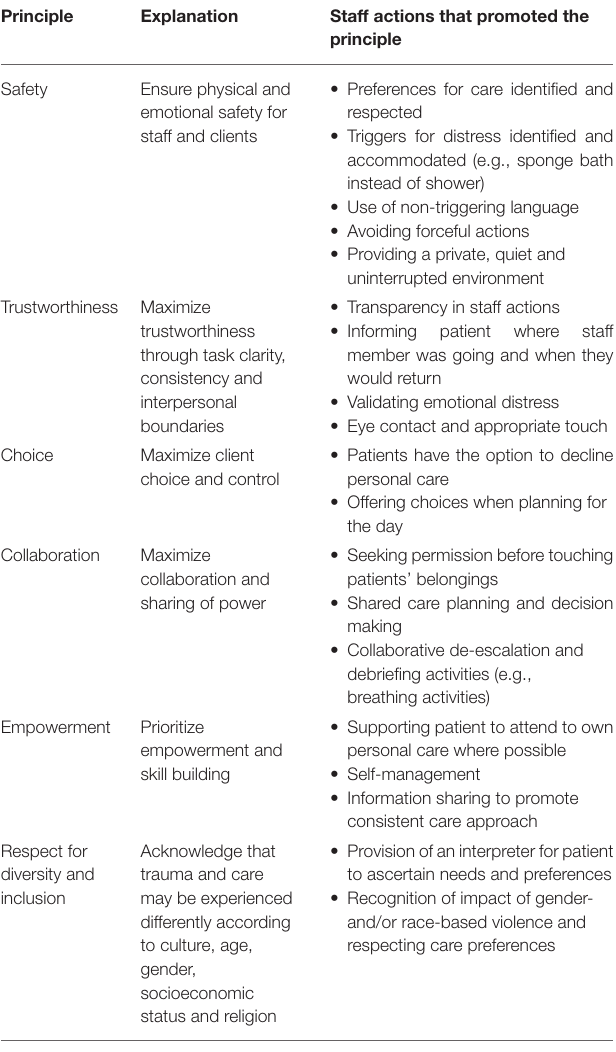
TABLE 1 | Staff actions demonstrated in case studies that promoted the principles of trauma-informed care